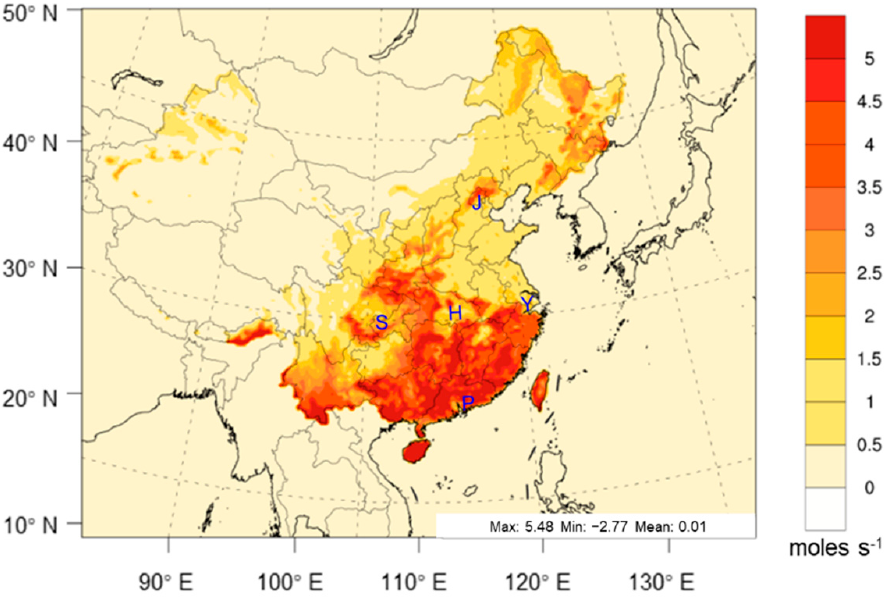
Figure 8. Impact of land-use changes on BVOC emission rates under the carbon scenario (Unit: moles s − 1 ).